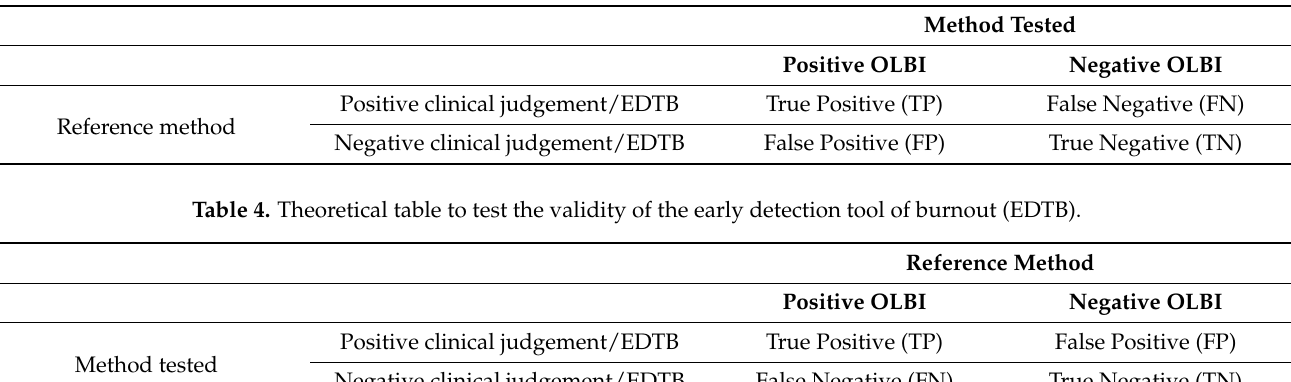
Table 3. Theoretical table to test the validity of the Oldenburg burnout inventory (OLBI).